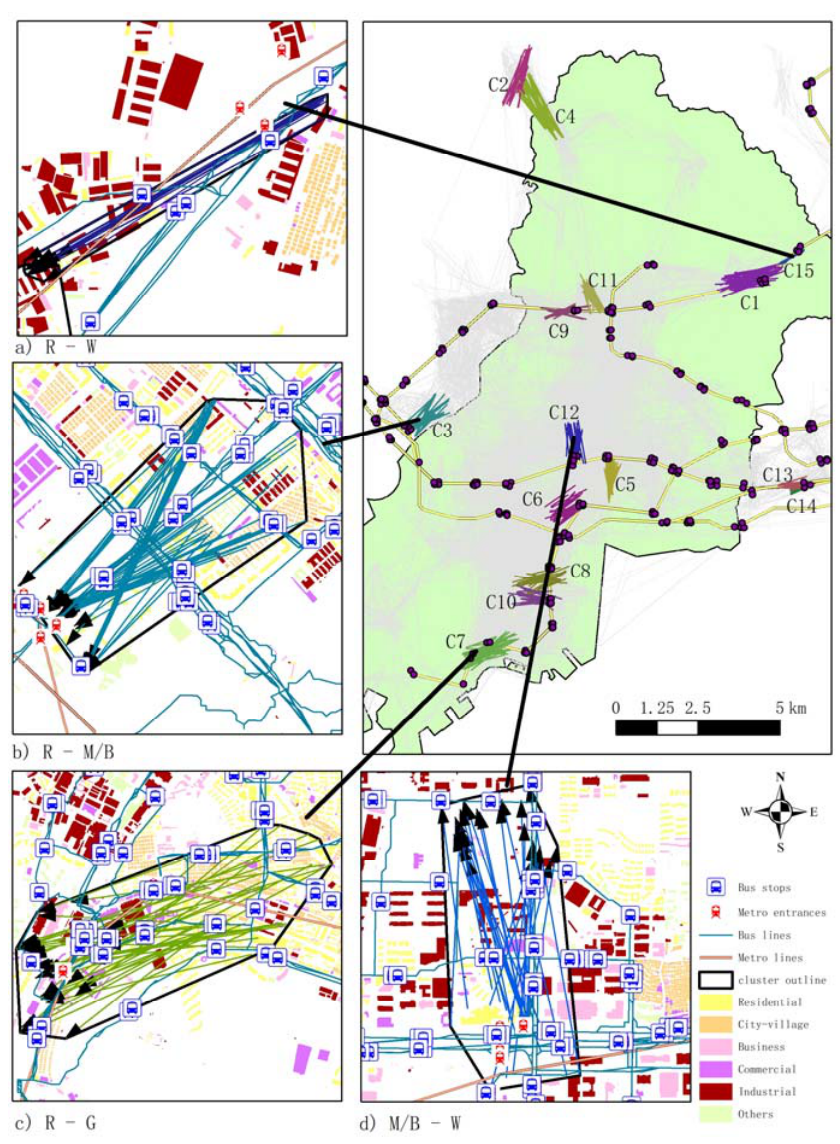
Figure 12. The results of the SCLM and typical clusters with different trip purposes.